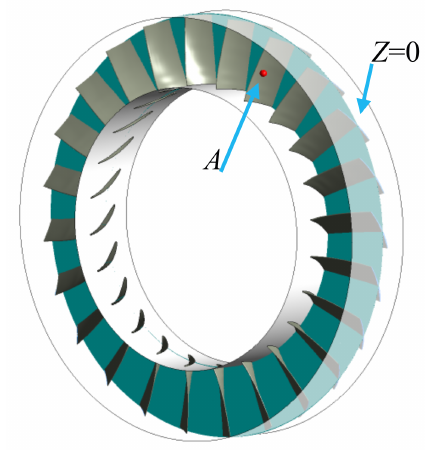
Figure 7. The location of Z = 0 cm section and monitoring point A.